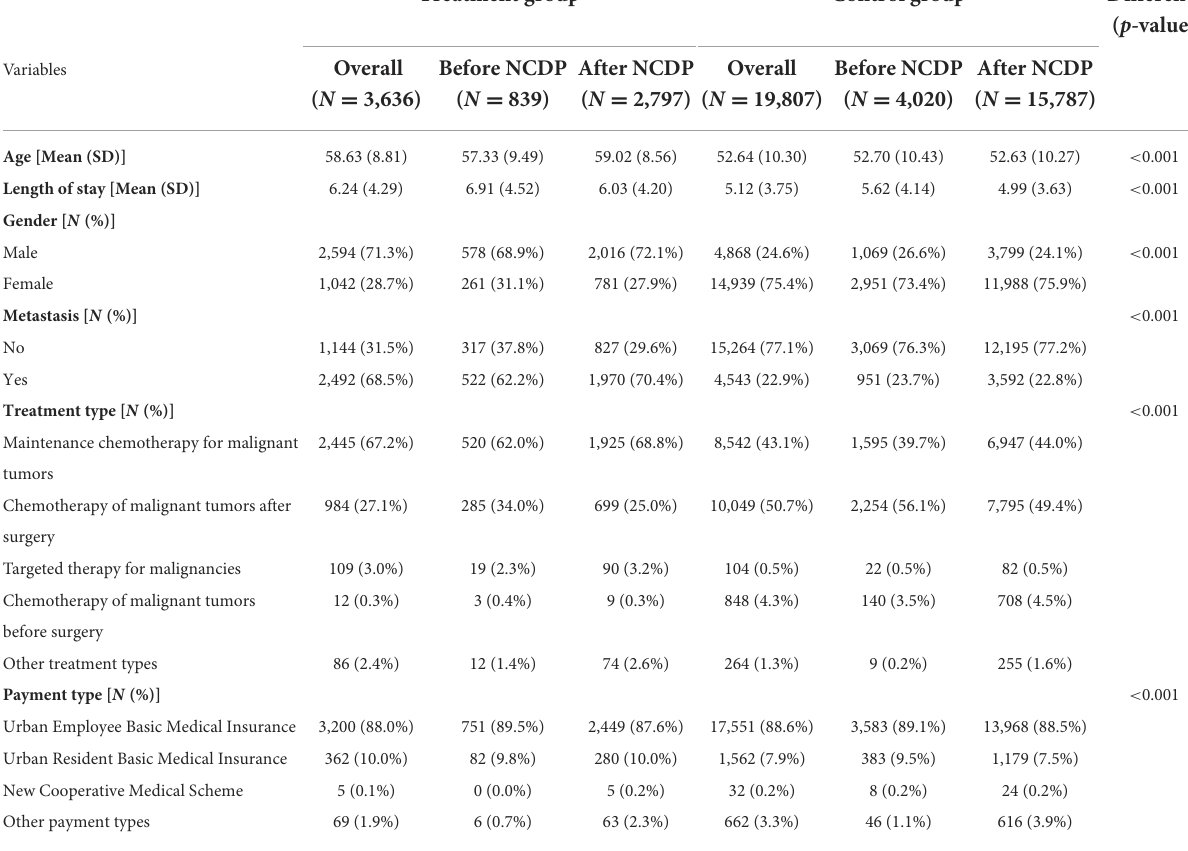
TABLE 2 Baseline characteristics for cancer patients in treatment group and control group. Treatment group Control